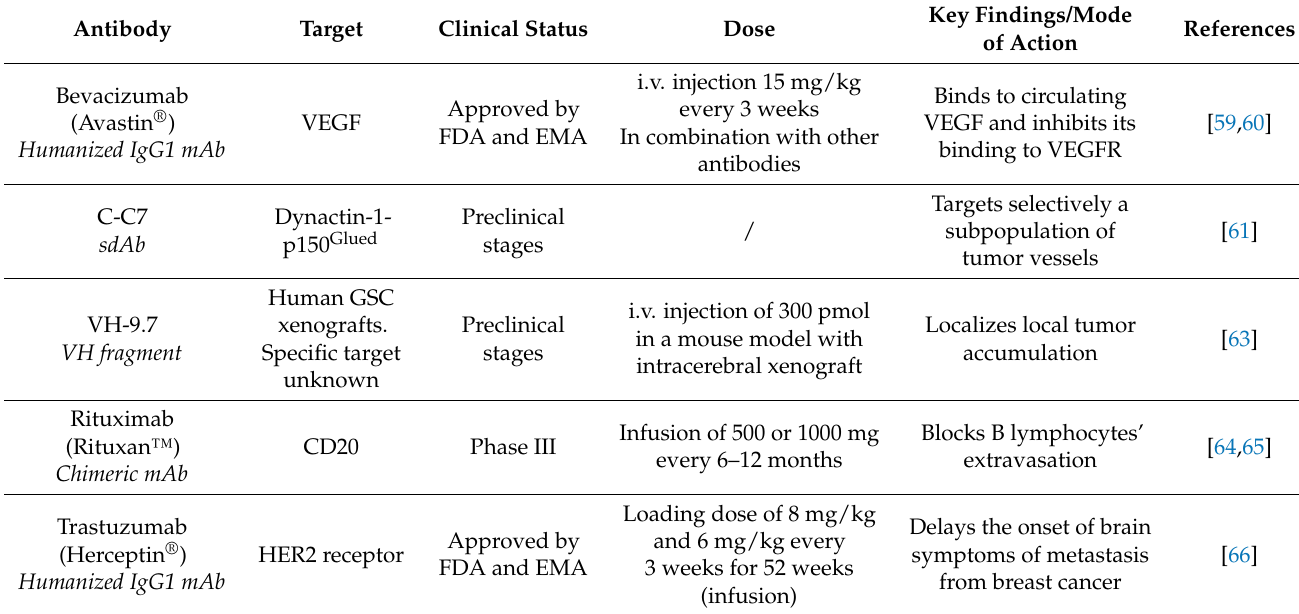
Table 3. Antibodies under investigation or approved for brain